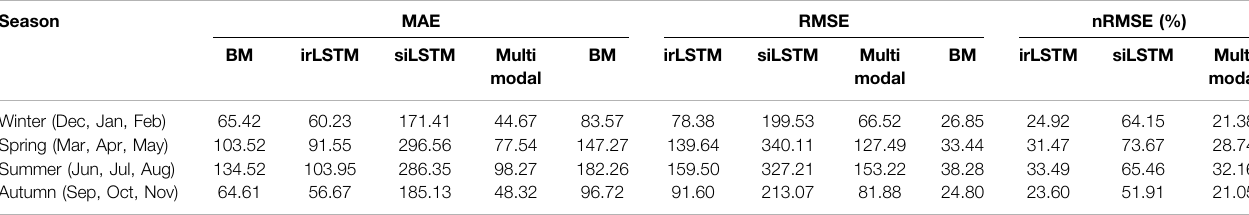
TABLE 3 | Comparison of nowcasting results of the multimodal model with before and after the Sun masking. Season MAE RMSE nRMSE (%) Before After Before Winter (Dec, Jan,